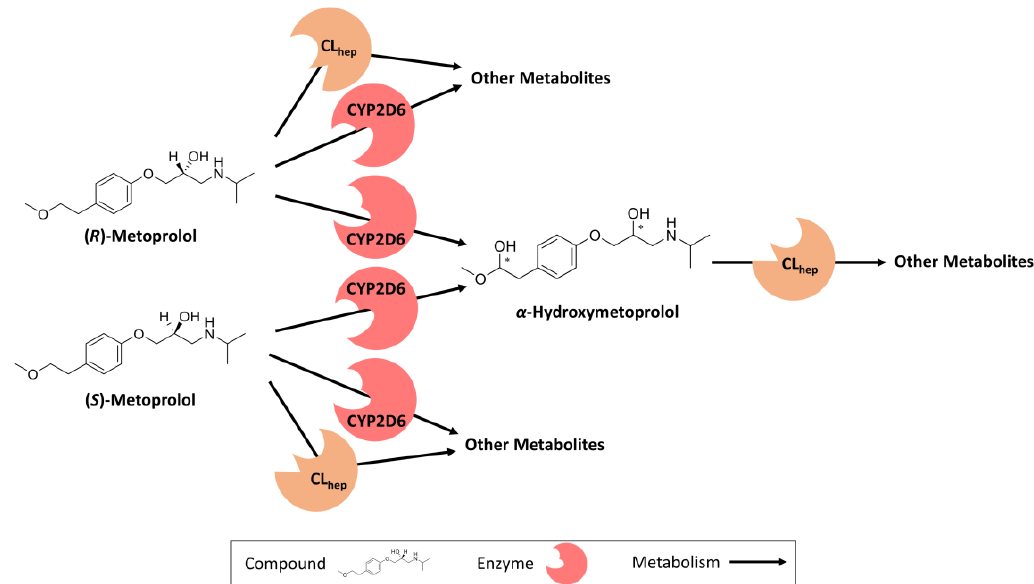
Figure 1. Implemented metoprolol metabolic pathways. ( R )- and ( S )-metoprolol are both metabolized via two di ff erent CYP2D6-dependent metabolic pathways: α -hydroxylation and O -demethylation, as well as by an unspecific hepatic clearance process. The four α -hydroxymetoprolol diastereomers (stereocenters are marked with asterisks) were modeled as one single compound due to